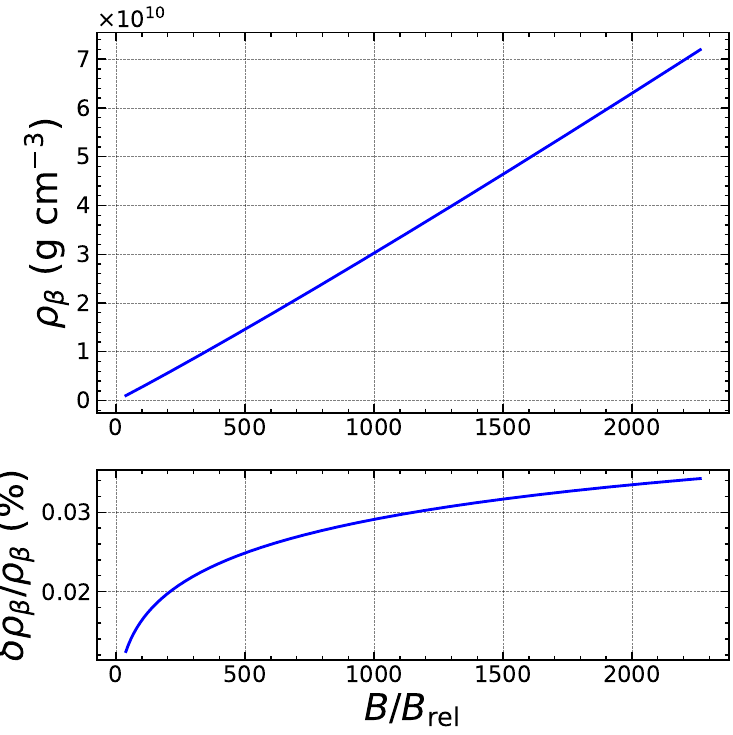
Figure 4. Same as Figure 3 in the strongly quantizing regime.